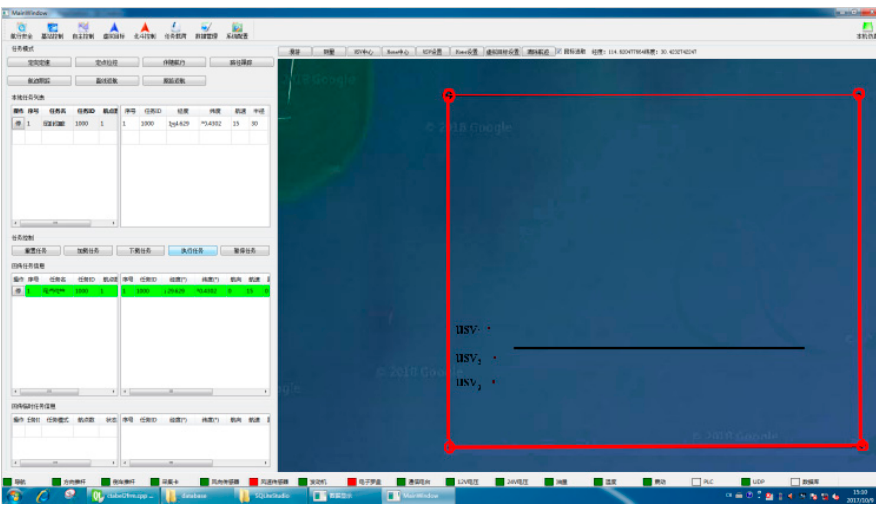
Figure 31. Setting interface for the expected path of USV 1 on basestation. Table 3. Initial parameters of USVs.